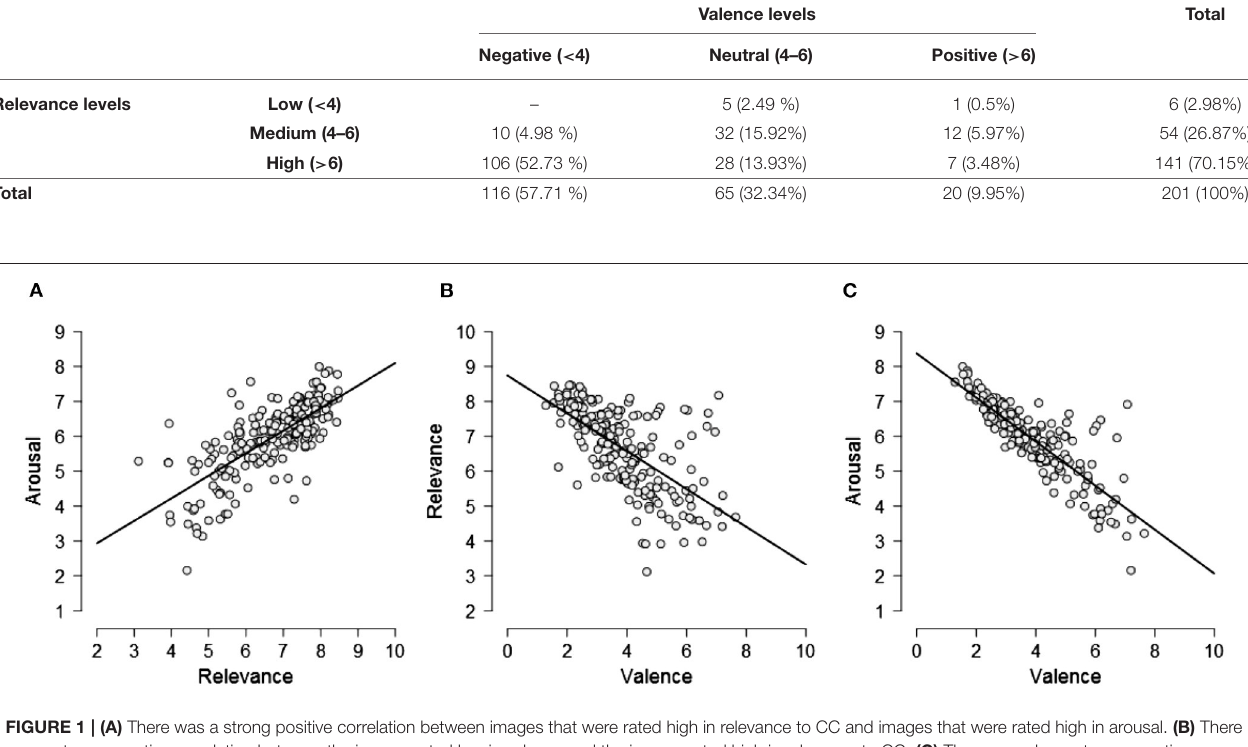
FIGURE 1 | (A) There was a strong positive correlation between images that were rated high in relevance to CC and images that were rated high in arousal. (B) There was a strong negative correlation between the images rated low in valence and the images rated high in relevance to CC. (C) There was also a strong negative correlation between the images rated low in valence and the images rated high in